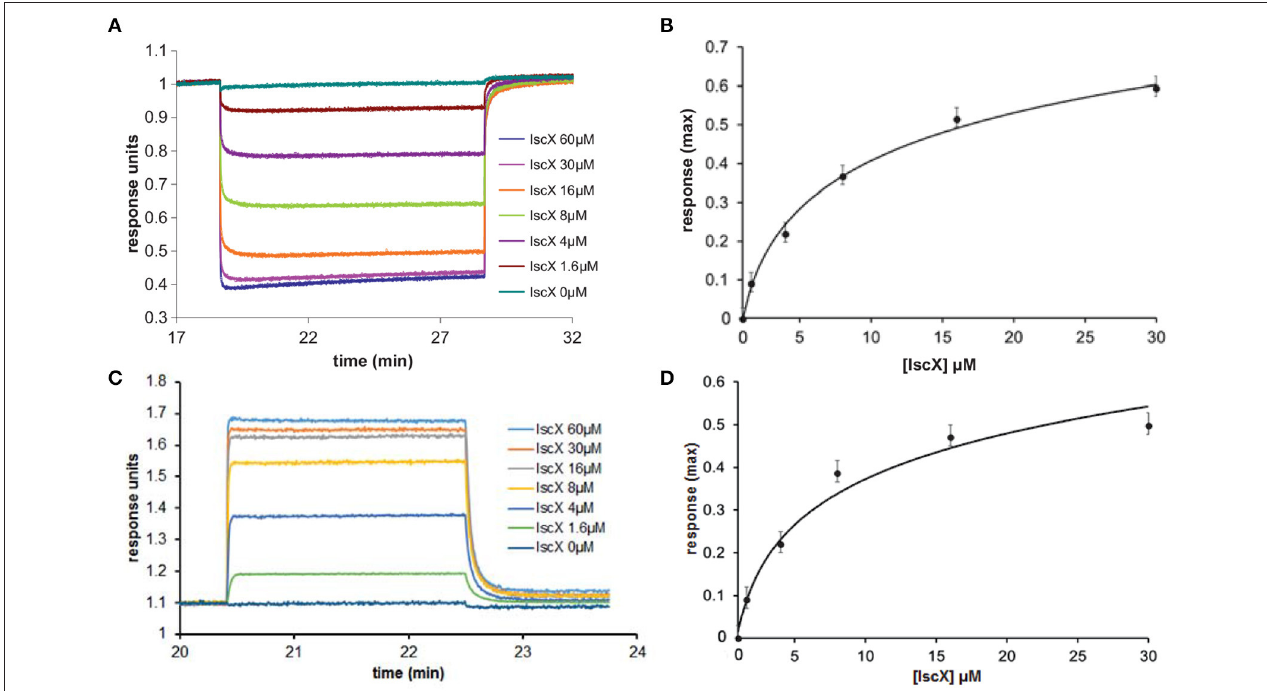
FIGURE 2 | Quantification of the binding affinities of the IscX-IscS-IscU and IscX-IscS complexes to assess the influence of a third component. (A) Plot of the interferometry response obtained by immobilizing CyaY saturated by IscS (10 µ M) and titrating with increasing concentrations of IscX (0–60 µ M). (B) Plot of the response reduction as a function of IscX concentration. (C) Plot of the interferometry response obtained by immobilizing IscS saturated by IscU (10 µ M) and titrating with increasing concentrations of IscX (0–60 µ M). (D) Plot of the response as a function of IscX concentrations.